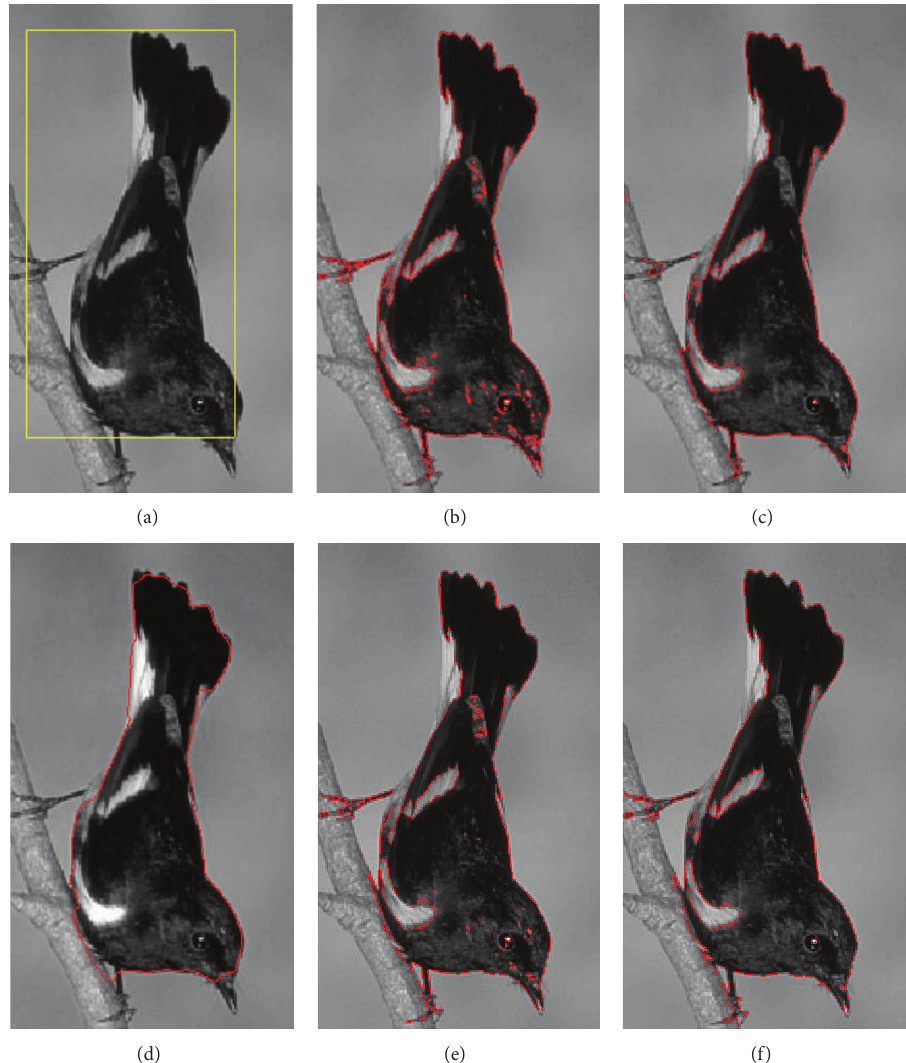
Figure 13: Segmentation results on the bird image: (a) the initial contour, (b) the CV model result, (c) the GACV model result, (d) the DRLSE model result, (e) the FAC model result, and (f) the LFAC model